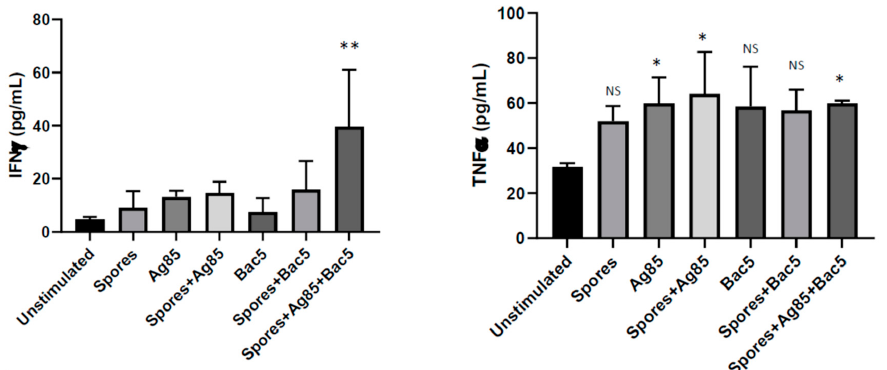
Figure 3. Cytokine Release by Stimulated Human Tonsil Cells. IFN γ and TNF α were quantified by ELISA from the cell culture supernatant of cells stimulated with either Bac 5 (10 ng/mL), B. subtilis spores (100:1 ratio to cells), Ag85B (5 µg/mL), or combinations as described. Absorbance was recorded at 450 nm and one-way ANOVA performed to establish statistical significance of each condition versus the unstimulated control (** = p < 0.01, * = p < 0.1, NS = No Significance) from triplicate technical